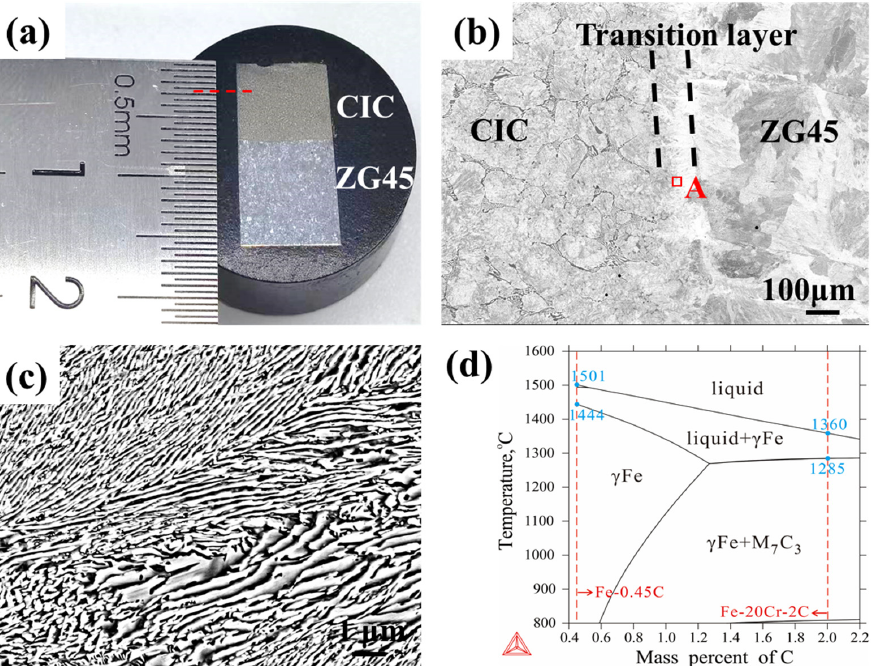
Figure 6. ( a ) Macrograph of as ‐ cast CIC ‐ 3; ( b ) SEM micrograph of as ‐ cast CIC ‐ 3 at the interface; ( c ) SEM micrograph of region A in ( b ); ( d ) calculated vertical section along the compositions from Fe–0.45C (wt.%) to Fe–20Cr–2C